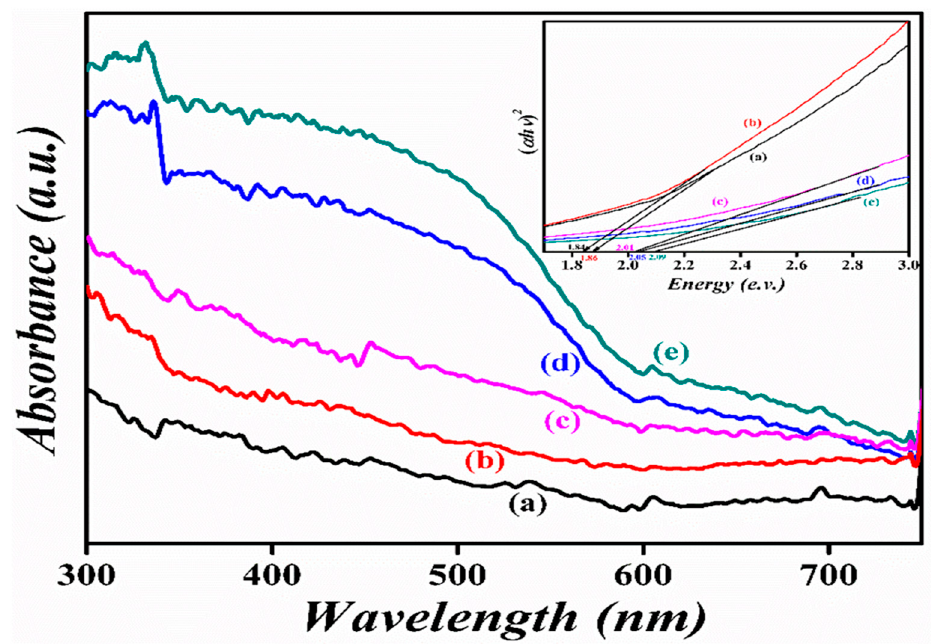
Figure 5. The diffuse reflectance spectra of (a) LBF–G, (b) LBFSe10–G, (c) LBFSe25–G, (d) LBFSe50–G, and (e) LBFSe100–G.